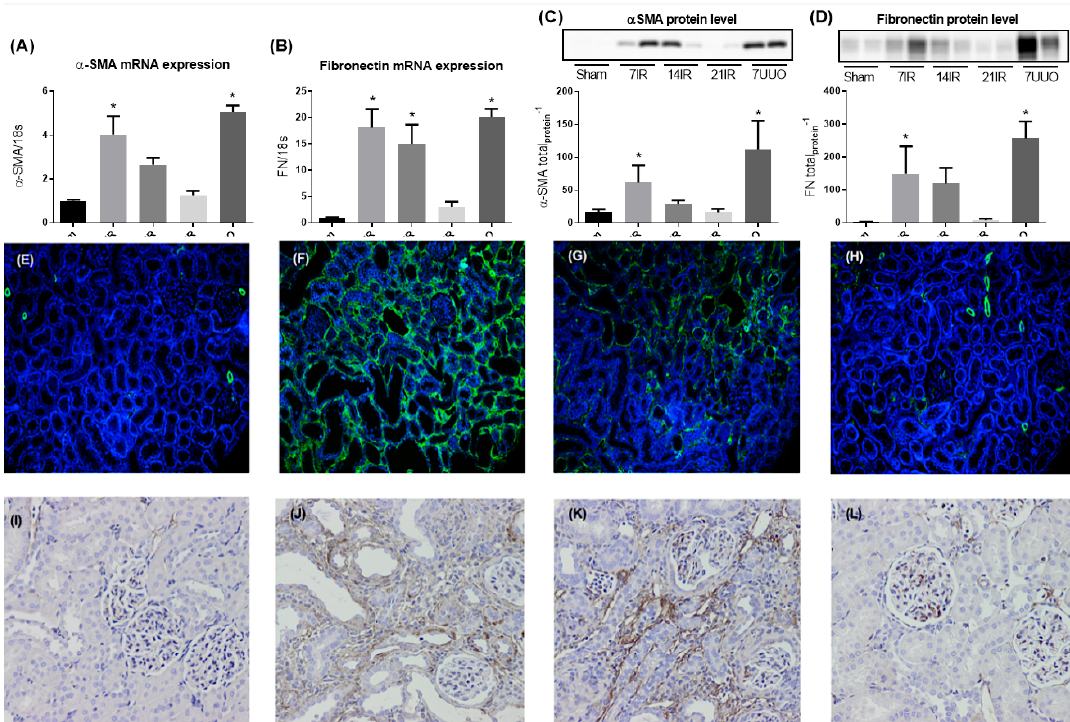
Figure 2. Fibrosis markers in renal tissue: ( A ) mRNA expression of α SMA and ( B ) fibronectin both normalized to the ribosomal protein 18S; ( C ) western blot analysis of α SMA, including band 42 kDa, normalized to total protein content; and ( D ) western blot of fibronectin, including band 260 kDa, normalized to total protein content. ANOVA with Bonferroni multiple comparison test was performed between sham, IRI, and UUO. Each bar represents the mean ± SEM, * p < 0.05 compared to sham group. Representative α SMA immunofluorescence (IF) stain of ( E ) sham ( n = 6), ( F ) 7 days after bilateral IRI ( n = 6), ( G ) 14 days after bilateral IRI ( n = 4), and ( H ) 21 days after bilateral IRI ( n = 5): Similarly, representative FN immunohistochemistry (IHC) stains of ( I ) sham, ( J ) 7 days after bilateral IRI, ( K ) 14 days after bilateral IRI, and ( L ) 21 days after bilateral IRI. IF magnification 4 × , IHC magnification 10 ×